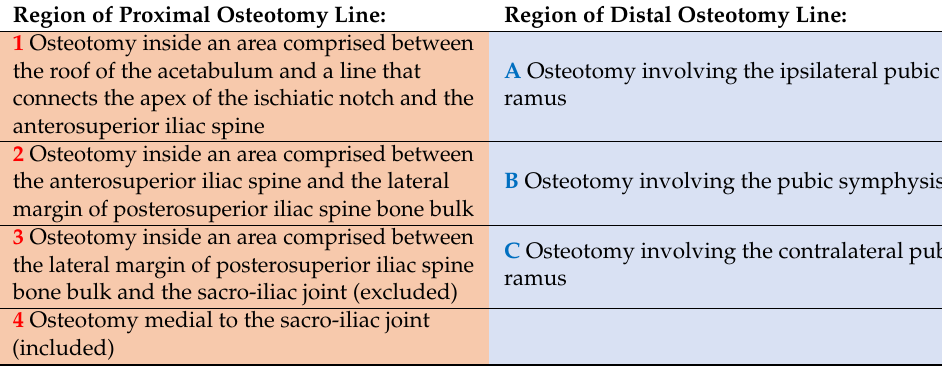
Table 1. Classification